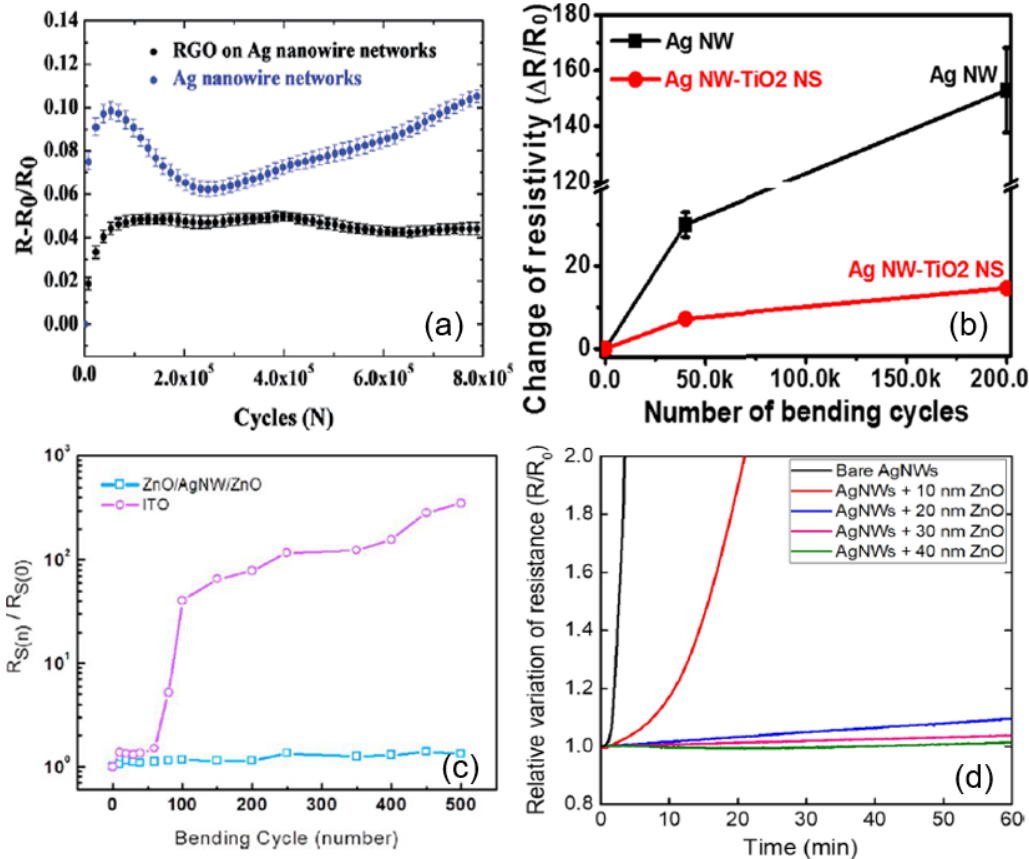
Figure 16. Comparative cyclic bending test results as a function of time or cycle number for ( a ) Ag NW networks and Ag NW–RGO hybrid after exposure at 70 ◦ C for 132 h. Reproduced with permission from [66]. Copyright 2016 Royal Society of Chemistry. ( b ) TiO 2 NS–Ag NW hybrid and Ag NW under 6.7% bending strain. Reprinted with permission from [65]. Copyright 2018 American Chemical Society. ( c ) ITO single layer and ZnO–Ag NW–ZnO composite on polymer substrates. Reproduced with permission from [61]. Copyright 2013 American Chemical Society. ( d ) Bare Ag NW and